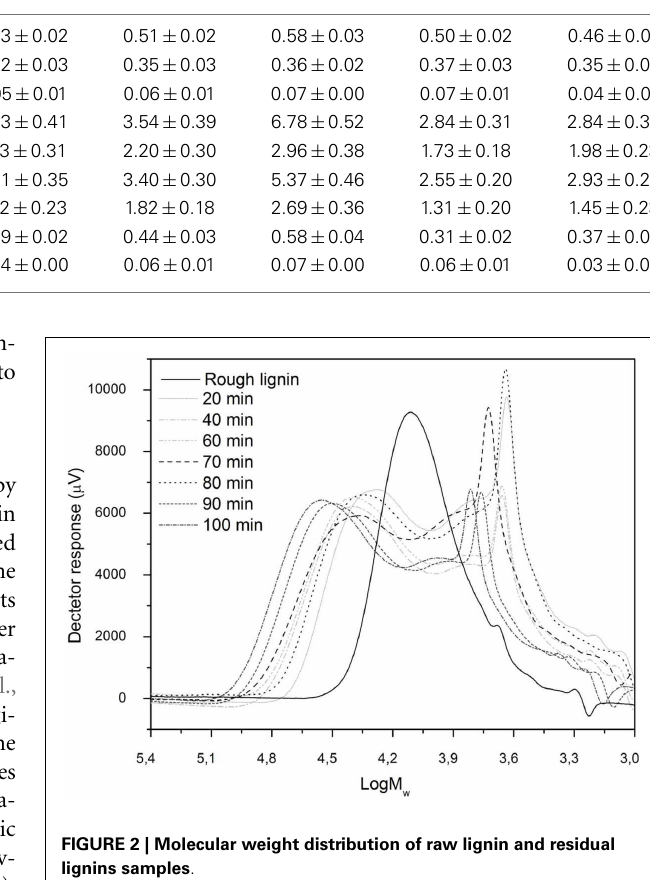
Table 2 | Phenolic monomers concentration in the oil analyzed by GC–MS (% w/w). Compound 20min